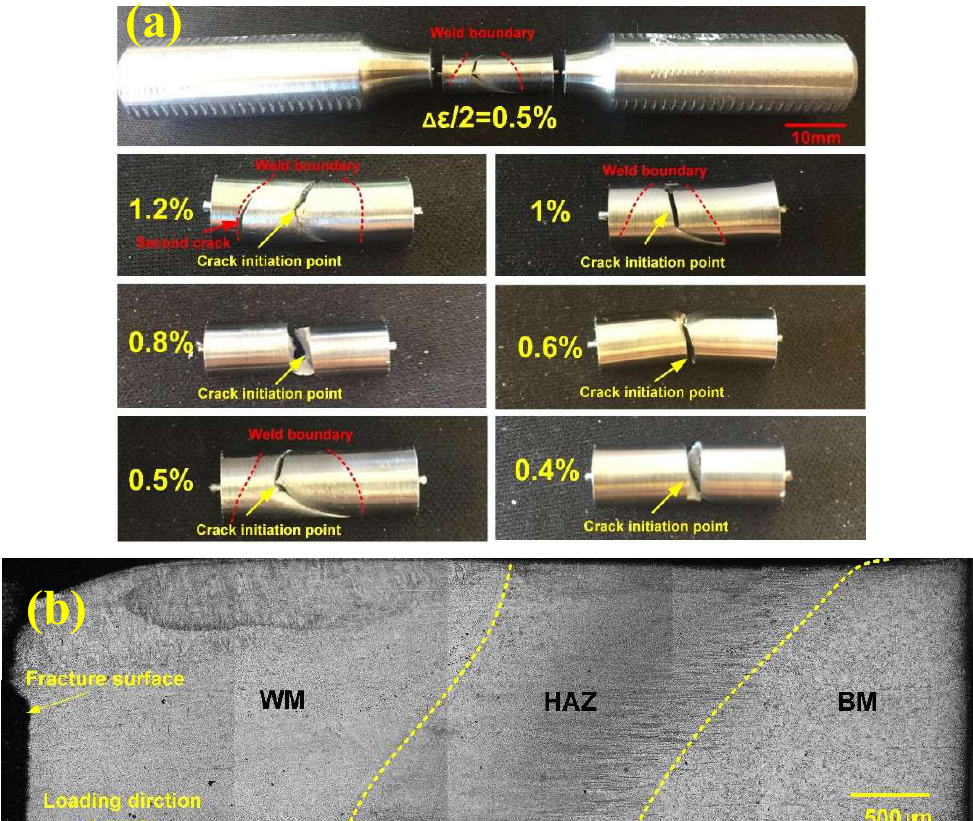
Figure 15. LCF fracture location of the welded joint under different strain amplitudes: ( a ) Macro morphology; ( b ) Optical images for microstructure.